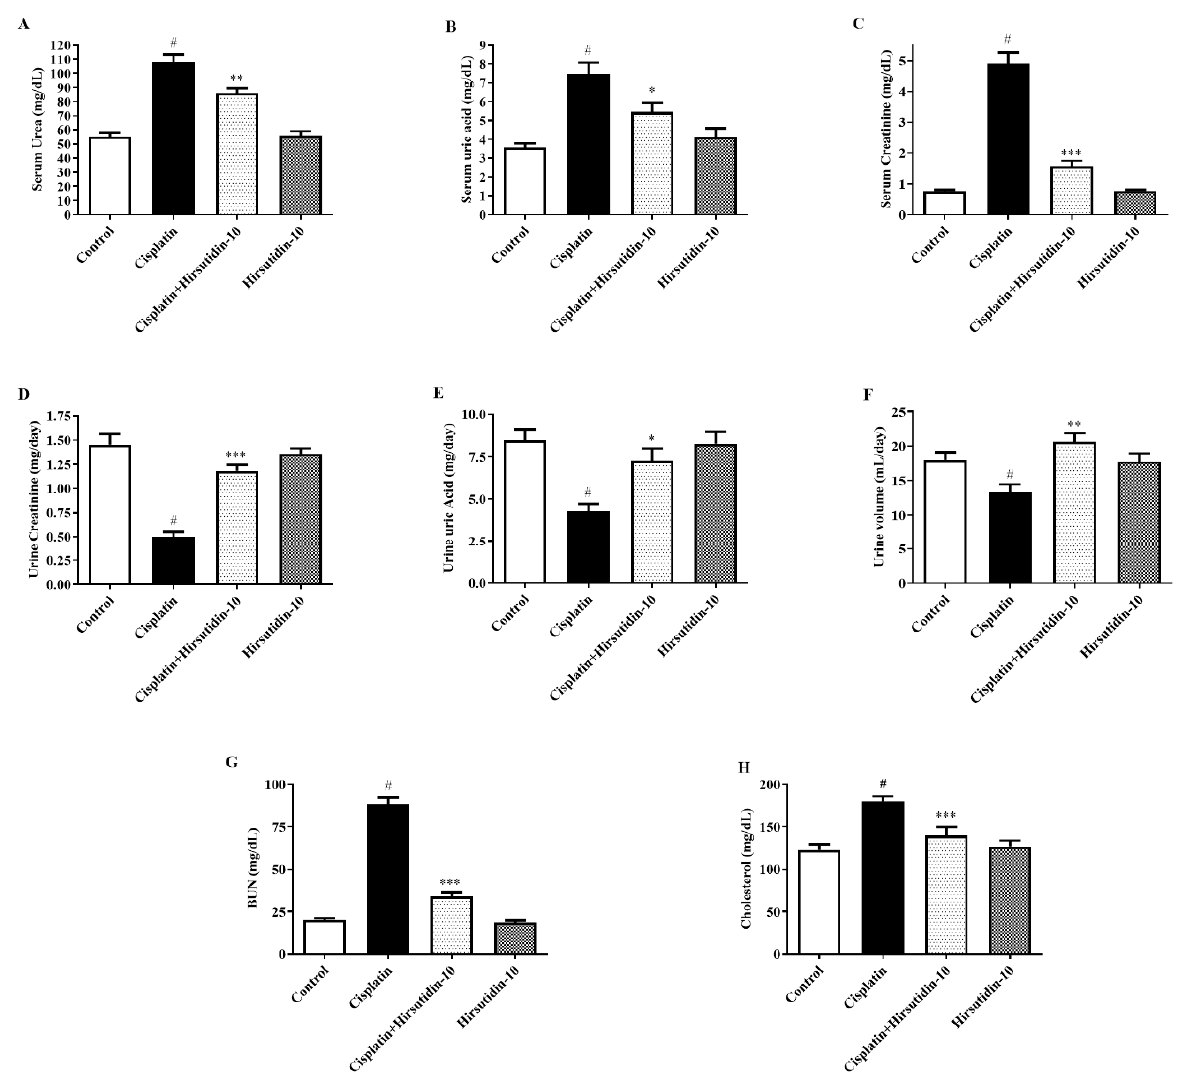
Figure 1. ( A – H ) Effect of hirsutidin on the evaluation of non-protein-nitrogenous components against nephrotoxicity induced in rats by cisplatin. ( A ) Serum urea. ( B ) Serum uric acid. ( C ) Serum creatinine. ( D ) Urine creatinine. ( E ) Urine uric acid. ( F ) Urine volume. ( G ) BUN. ( H ) Cholesterol. Mean ± SEM (n = 6). One-way ANOVA followed by Tukey’s post-hoc test. # p < 0.001 vs. control (group I), * p < 0.05, ** p < 0.01, *** p < 0.001 vs. cisplatin (group